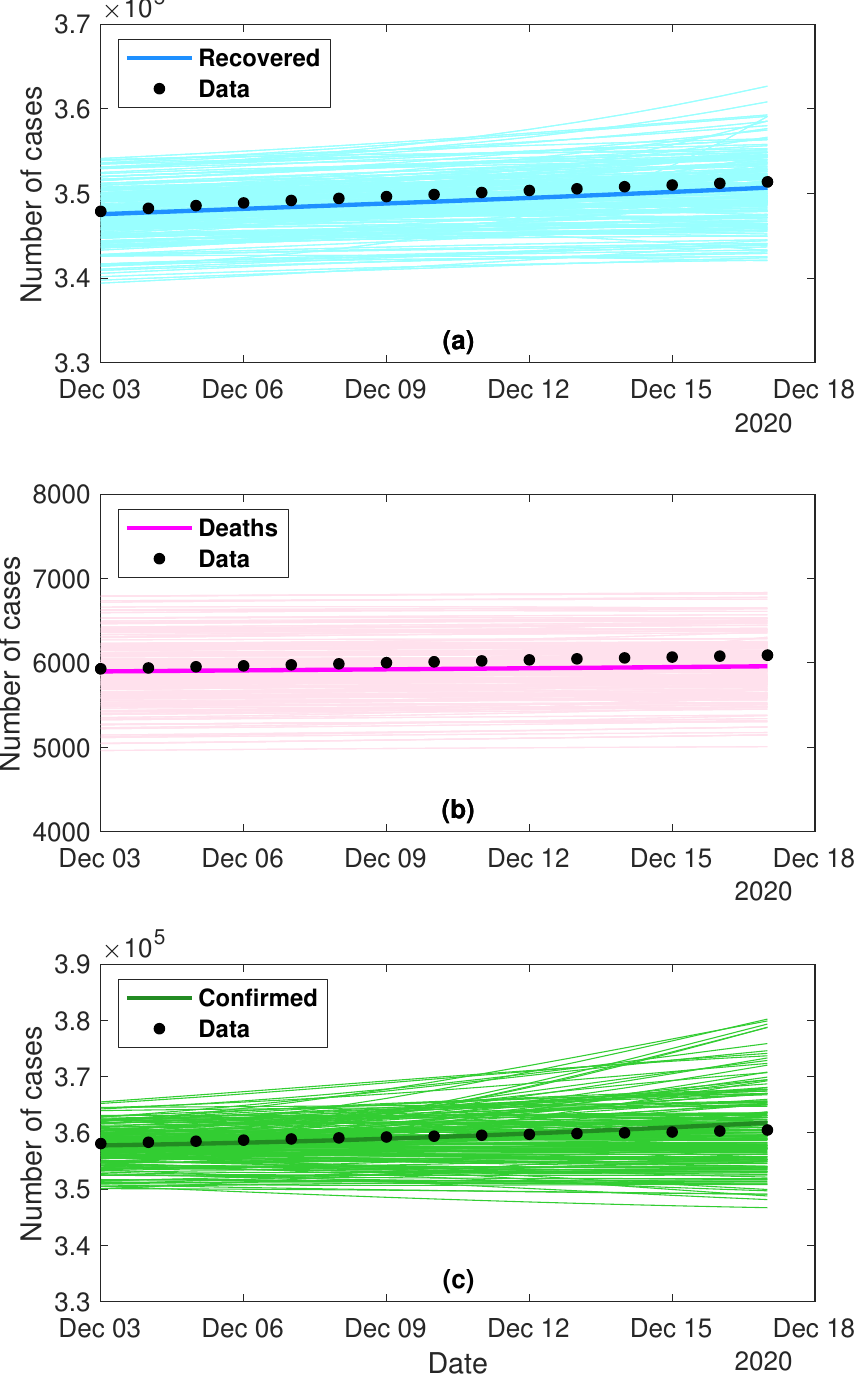
Figure 6. Predicted numbers of: ( a ) Recovered cases. ( b ) Death cases. ( c ) Confirmed cases for the first two weeks of